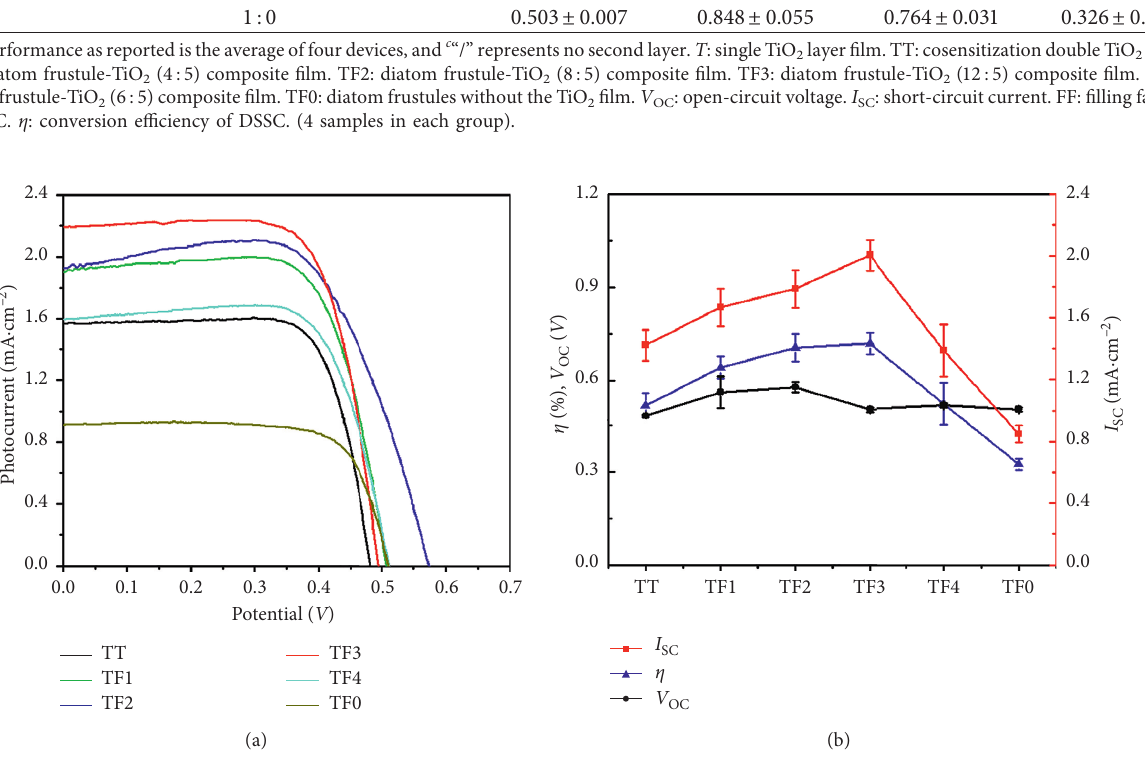
Table 2: Photovoltaic parameters b of NA56 pigment extract-sensitized diatom frustule-TiO Sample